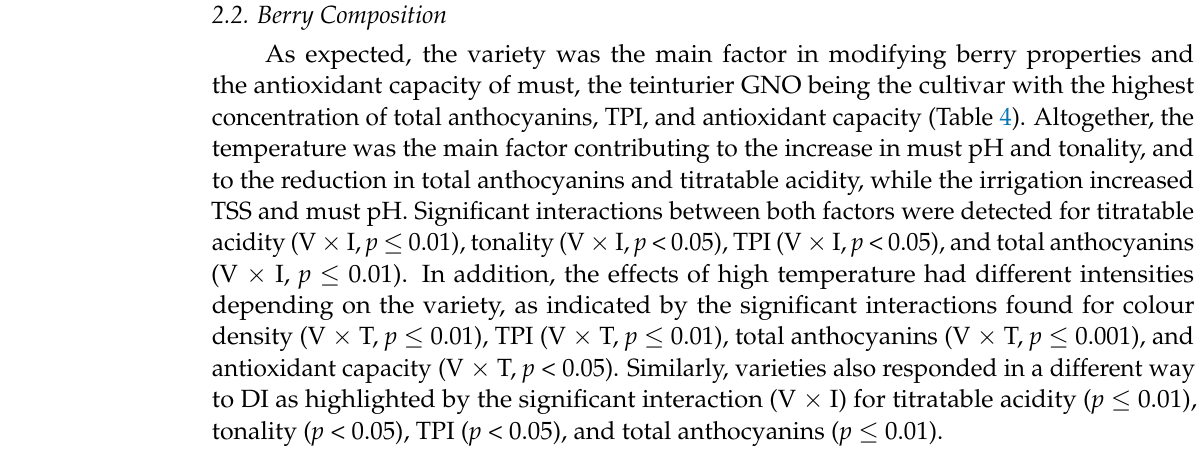
Table 4. Main effects and their interactions on berry quality and antioxidant capacity from fruit- bearing cuttings of different ancient wine grape varieties grown either at ambient (AT) or elevated temperature (ET) and subjected to different irrigation regimes (FI, full irrigation; DI, deficit irrigation). The variety labels can be found in Table